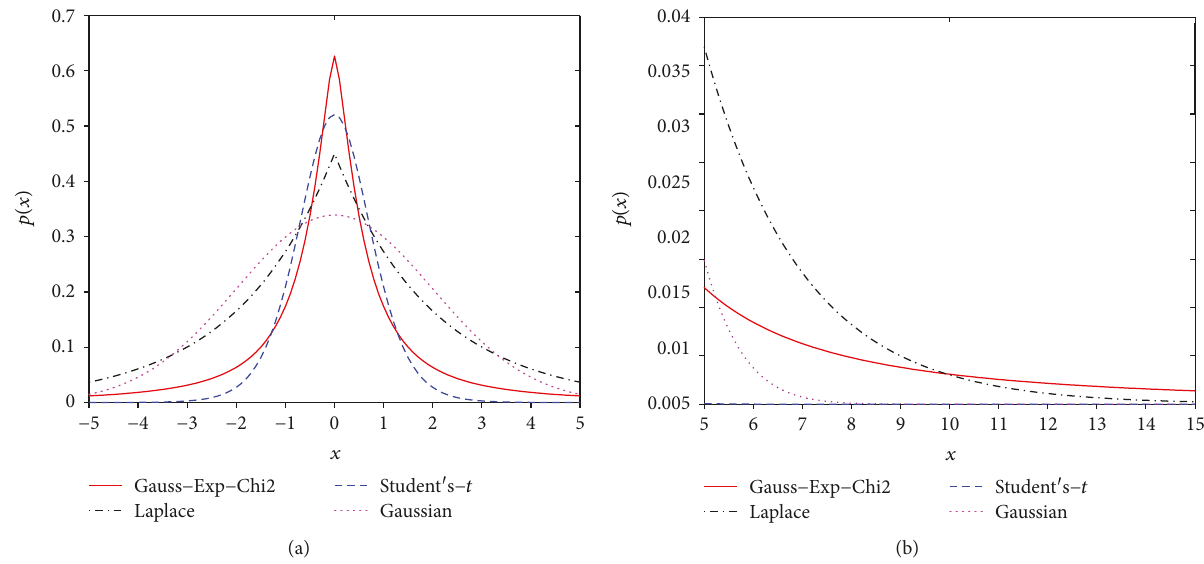
Figure 2: Four kinds of pdf curves with the standard derivation: (a) compares four distributions at origin and (b) compares four distributions in